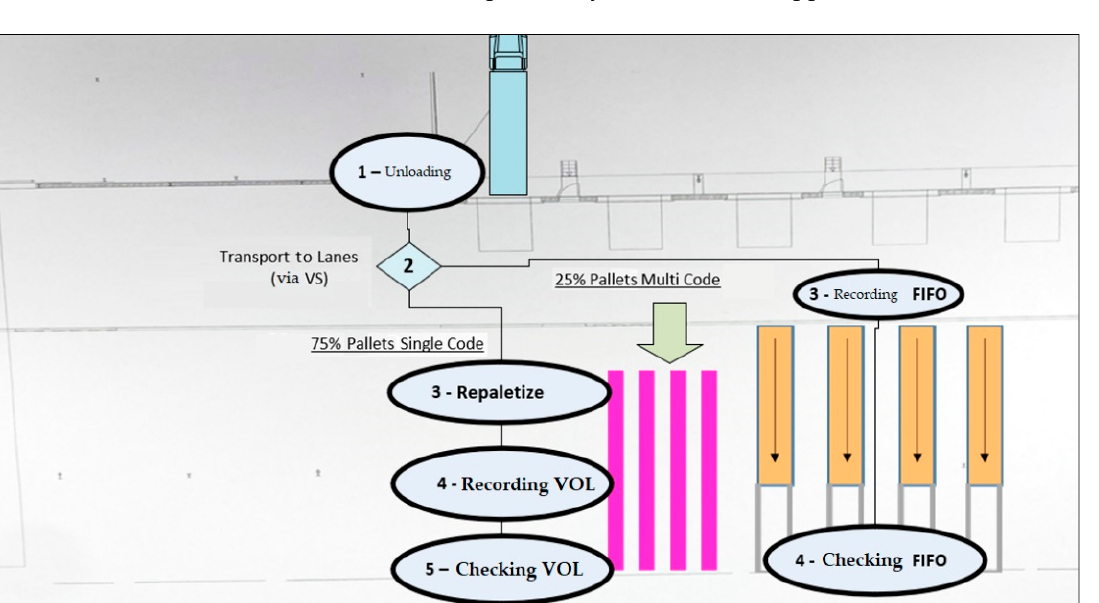
Figure 11. Comparison chart of several scenarios.